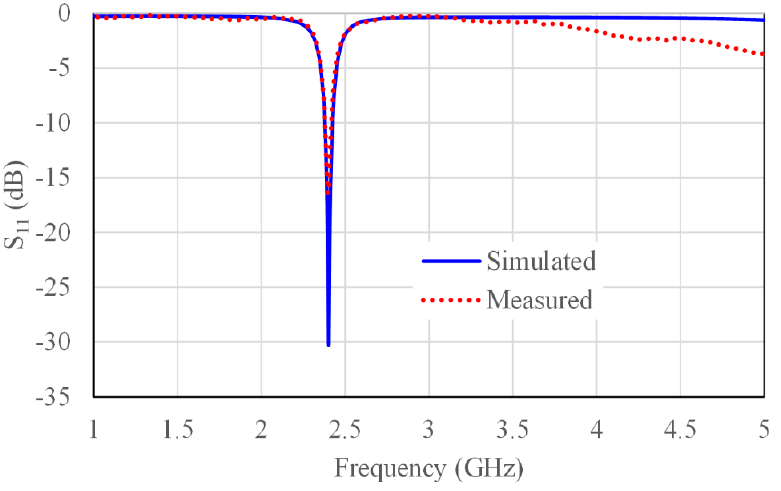
Figure 18. Simulated and measured return loss (S 11 ) of the single-fed single-band slotted square antenna.